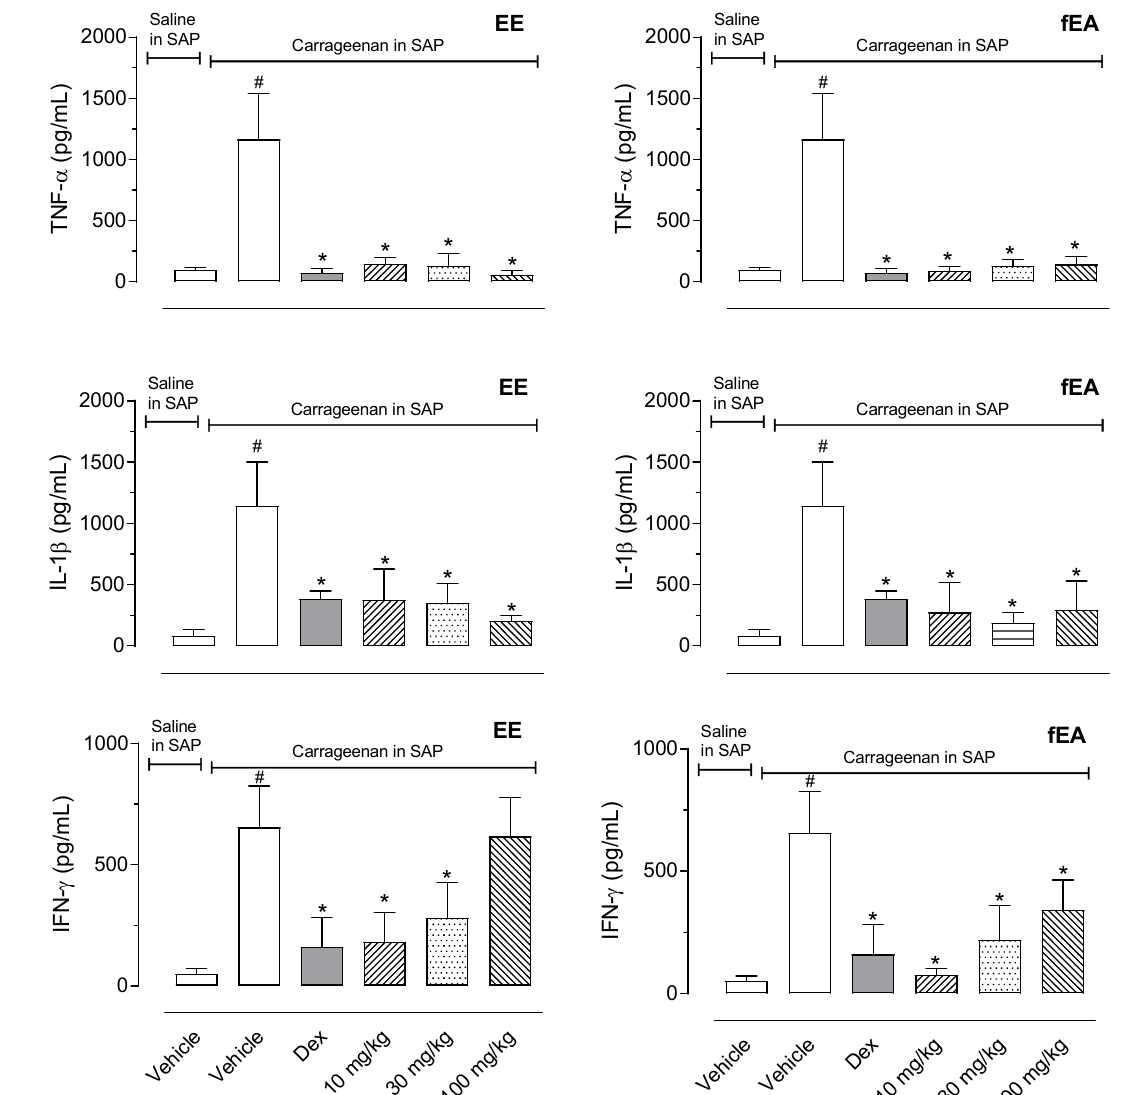
Figure 5. Effect of the ethanol extract (EE) and fraction in ethyl acetate (fEA) from leaves of T. granulosa in TNF- α , IL-1 β , and IFN- γ production in the SAP. The animals were pre-treated with vehicle, dexamethasone (Dex, 0.5 mg/kg, i.p.), EE or fEA (10, 30 or 100 mg/kg), 60 min before the injection of carrageenan (1%) or saline into SAP. The results are presented as mean ± S.D. ( n = 7). The statistical significance was calculated comparing the groups pre-treated with EE, fEA, or dexamethasone with the group pre-treated with the vehicle, using ANOVA followed by the post-test of Newman–Keuls. # p < 0.05 when comparing the vehicle-treated group receiving carrageenan in SAP with the vehicle- treated group that received saline in SAP; * p < 0.05 when comparing dex-, EE- or fEA-treated groups that received carrageenan in SAP with the vehicle-treated group receiving carrageenan in SAP.